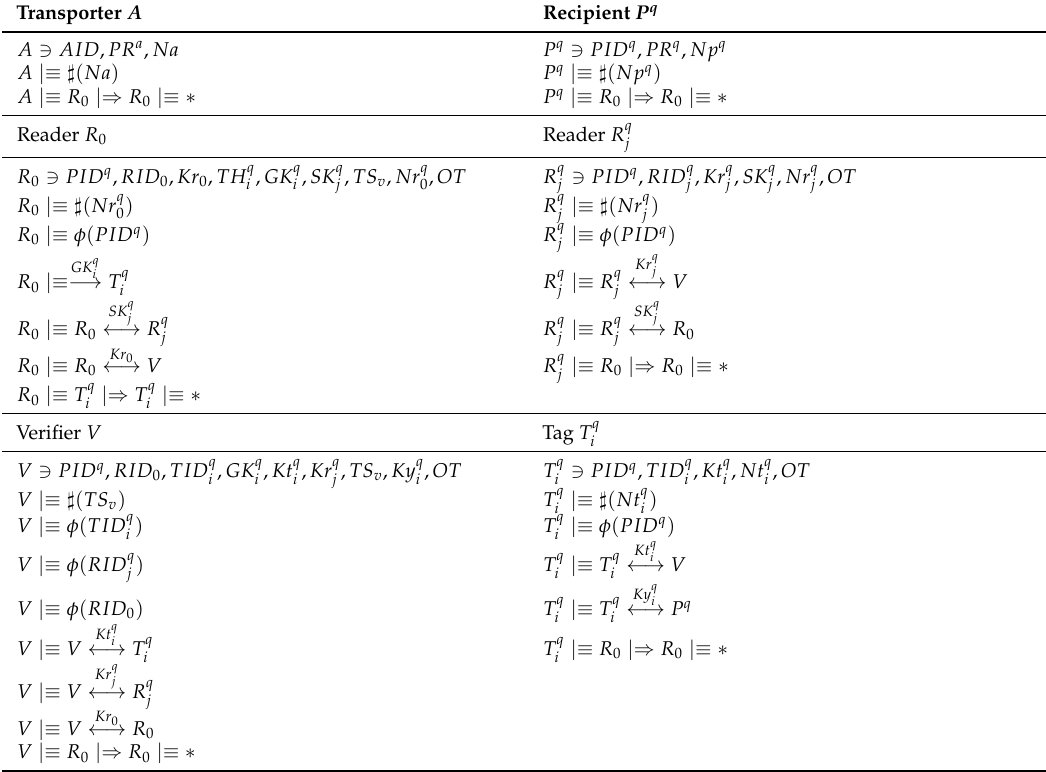
Table 8. Initial